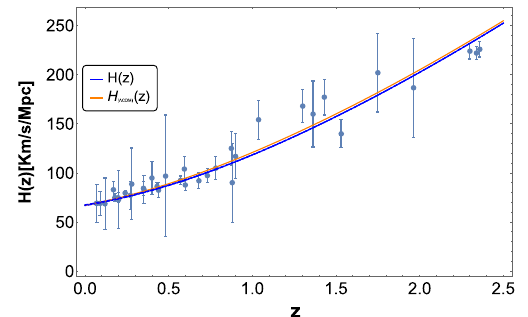
Fig. 5 We show the evolution of the Hubble rate H ( z ) as a function of the redshift z , for the values of parameters s = − 1 . 20, σ = 0 . 3 and λ = 150, and the same initial conditions used in Fig. 1, along with the evolution of the Hubble rate H Λ CDM ( z ) in the Λ CDM model and the Hubble data from Refs. [132,133]. We have used the current value of the Hubble rate H 0 = 67 . 4 km/(Mpc s) from Planck 2018 [7]